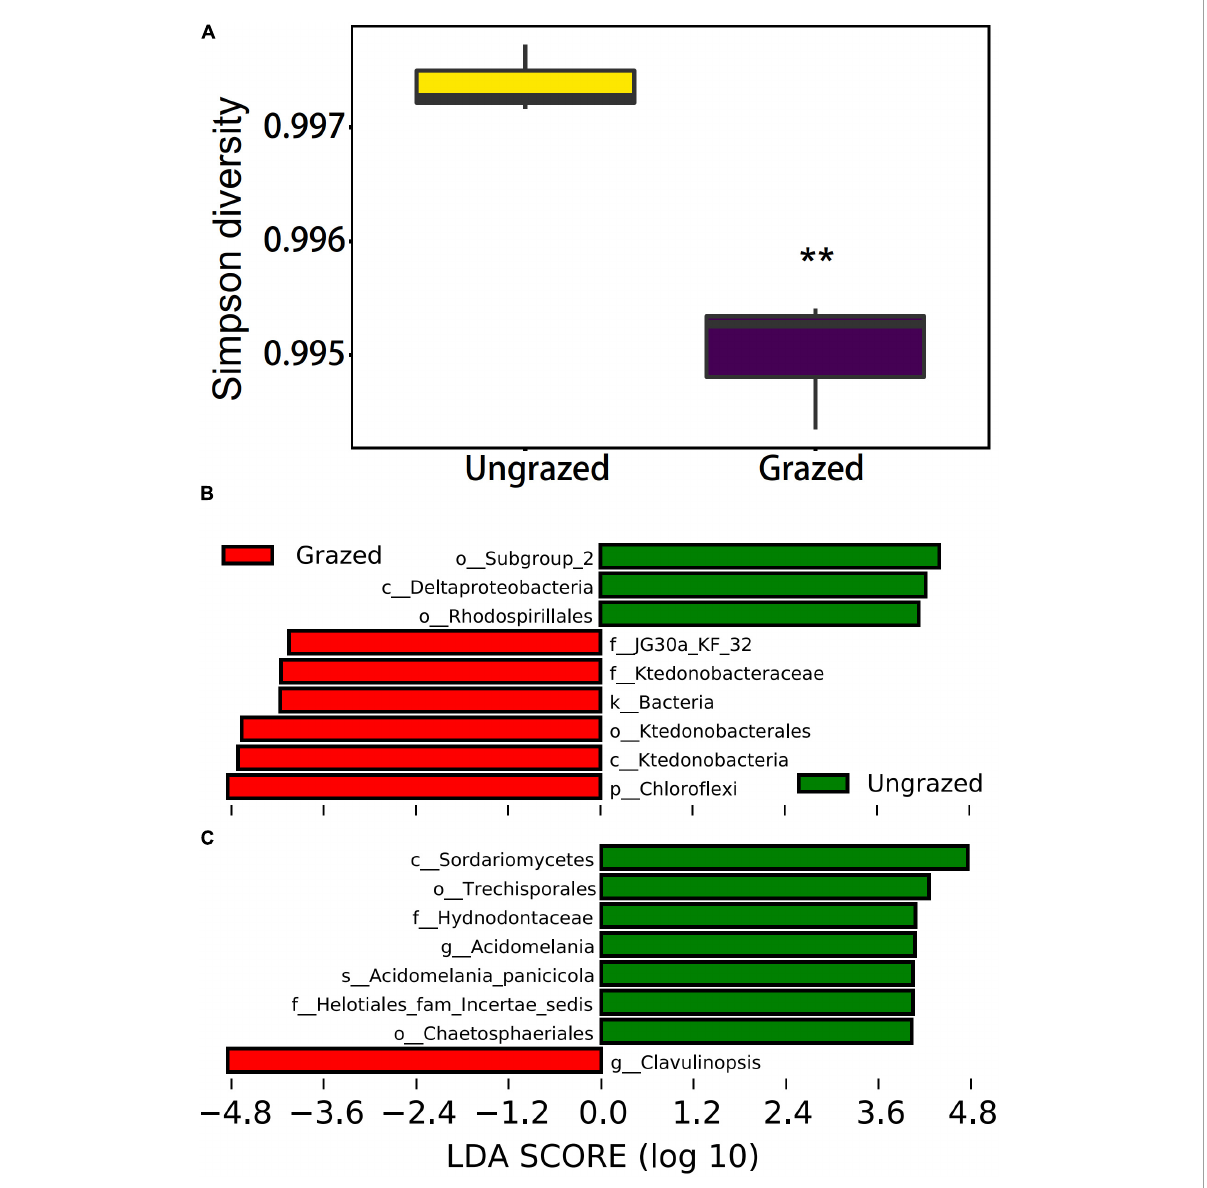
FIGURE3 Soil bacterial diversity (A) under grazed and ungrazed, and LEfSe analysis for bacterial (B) and fungal (C) communities showing the significantly enriched taxa under grazed and ungrazed. ** p <